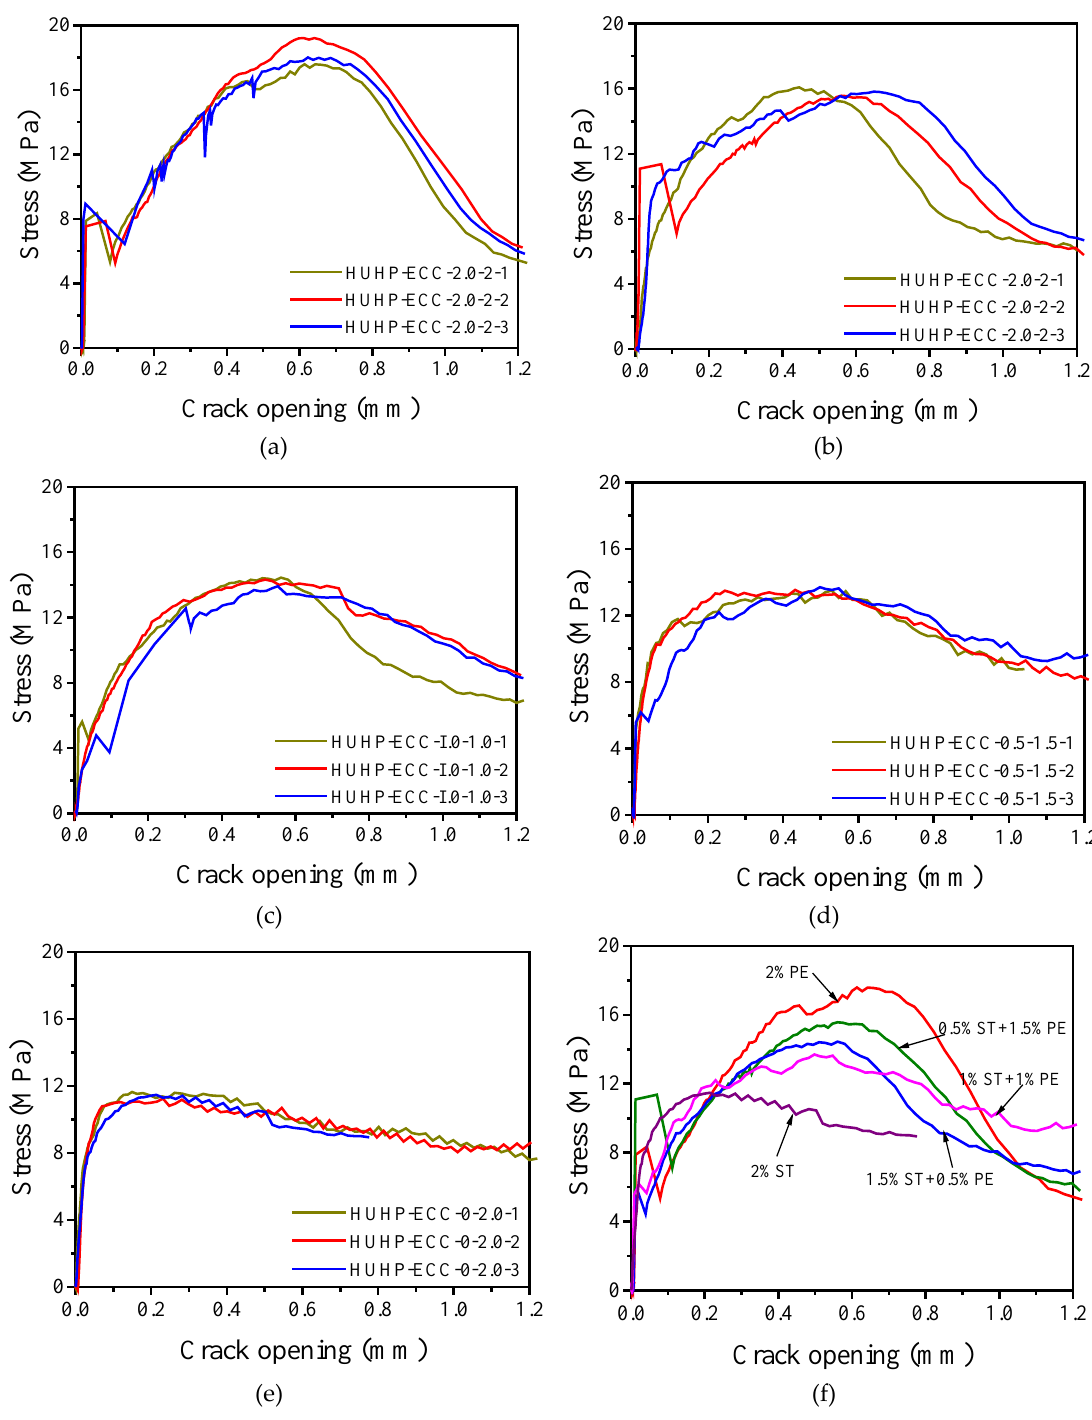
Figure 16. Bridging stress-crack opening displacement relationships. ( a ) Stress-crack opening curves of HUHP-ECC-2.0-0; ( b ) Stress-crack opening curves of HUHP-ECC-1.5-0.5; ( c ) Stress-crack opening curves of HUHP-ECC-1.0-1.0; ( d ) Stress-crack opening curves of HUHP-ECC-0.5-1.5; ( e ) Stress-crack opening curves of HUHP-ECC-0-2.0; ( f ) Stress-crack opening of different volume fractions of PE and ST fibers.